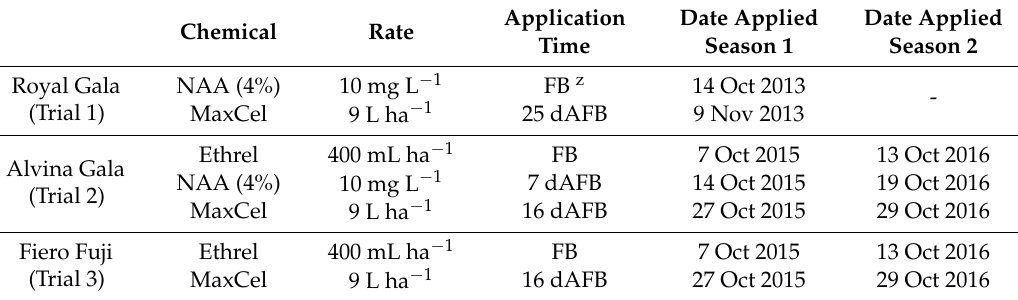
Ethrel FB MaxCel 9 L ha − 1 z FB = full bloom; dAFB = days after full